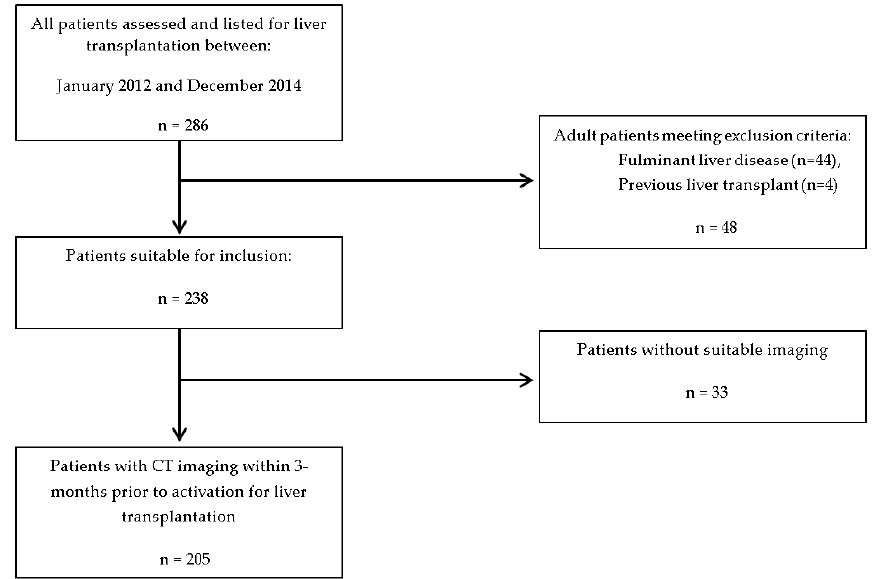
Figure 1. Patient selection. Study design and selection criteria of patients assessed for liver transplantation from 2012 to 2014.